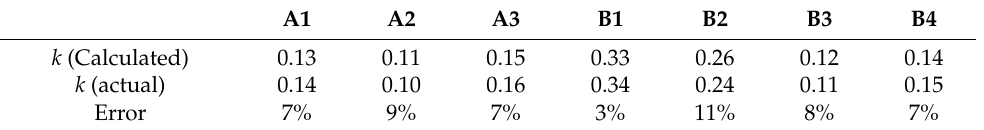
Figure 10. ( a ) Hole array distribution. ( b ) 3D model. ( c ) Prototype. Table 8. Error of equivalent elastic coefficient of each partition for men with small physique.